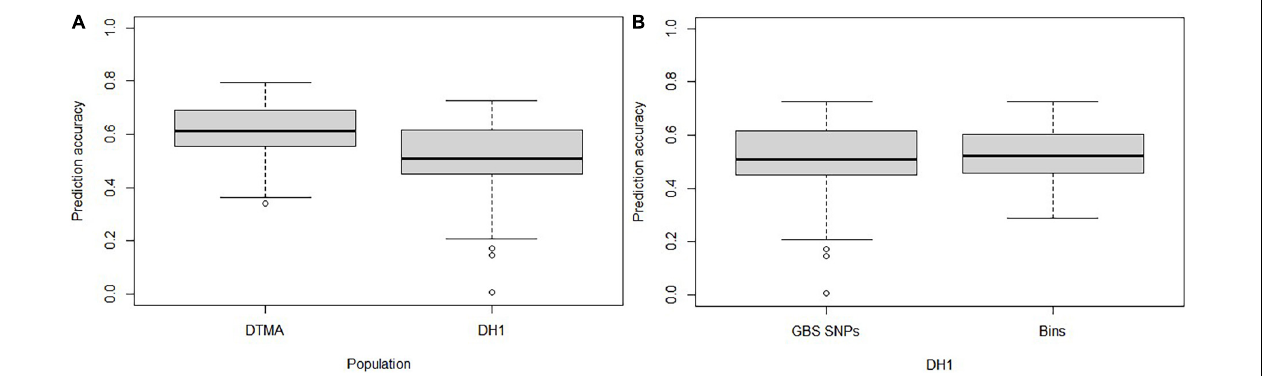
FIGURE 3 | Genomic prediction accuracy of common rust resistance in the DTMA panel and DH1 population. (A) In the DTMA panel and DH1 population estimated with genotyping-by-sequencing (GBS) single-nucleotide polymorphisms (SNPs); (B) in the DH1 panel estimated with GBS SNPs and